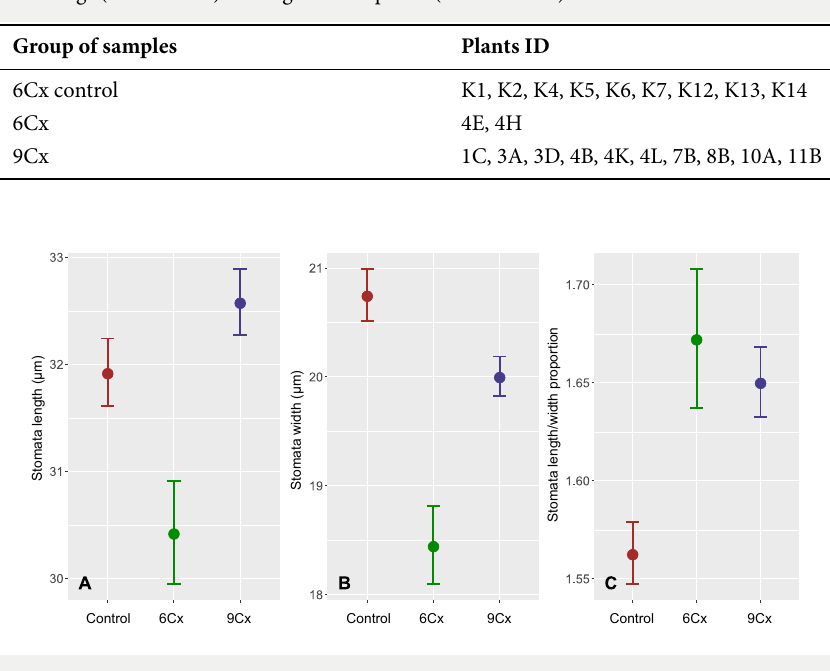
Figure 2 Mean length ( A ), width ( B ), and ratio of length to width ( C ) of the stomata in Actinidia chinensis var. deliciosa seedlings (6Cx control) and endosperm-derived plants (6Cx and 9Cx regenerants); error bars show 95% confidence